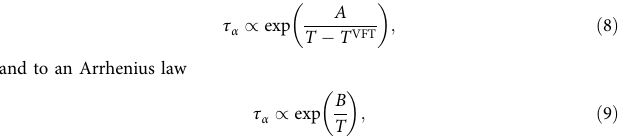
Fig. 3 Approaching the random fi rst-order transition. a Phase diagram showing the low- Q region for large cavities and high- Q region for small cavities, separated by the boundary determined by the point-to-set correlation length, ξ PTS . The dashed blue line is the same quadratic fi t (after unit conversion) as in Fig. 2b. Inset: Representative con fi gurations with overlap fi eld for T = 0.035 at R = 6.6 (low Q , white) and 4.8 (high Q , dark). b Evolution of the probability distribution function of overlap P ( Q ) at T = 0.035 from R = 4.8 to R = 6.6. Bimodality signals a fi rst-order-like